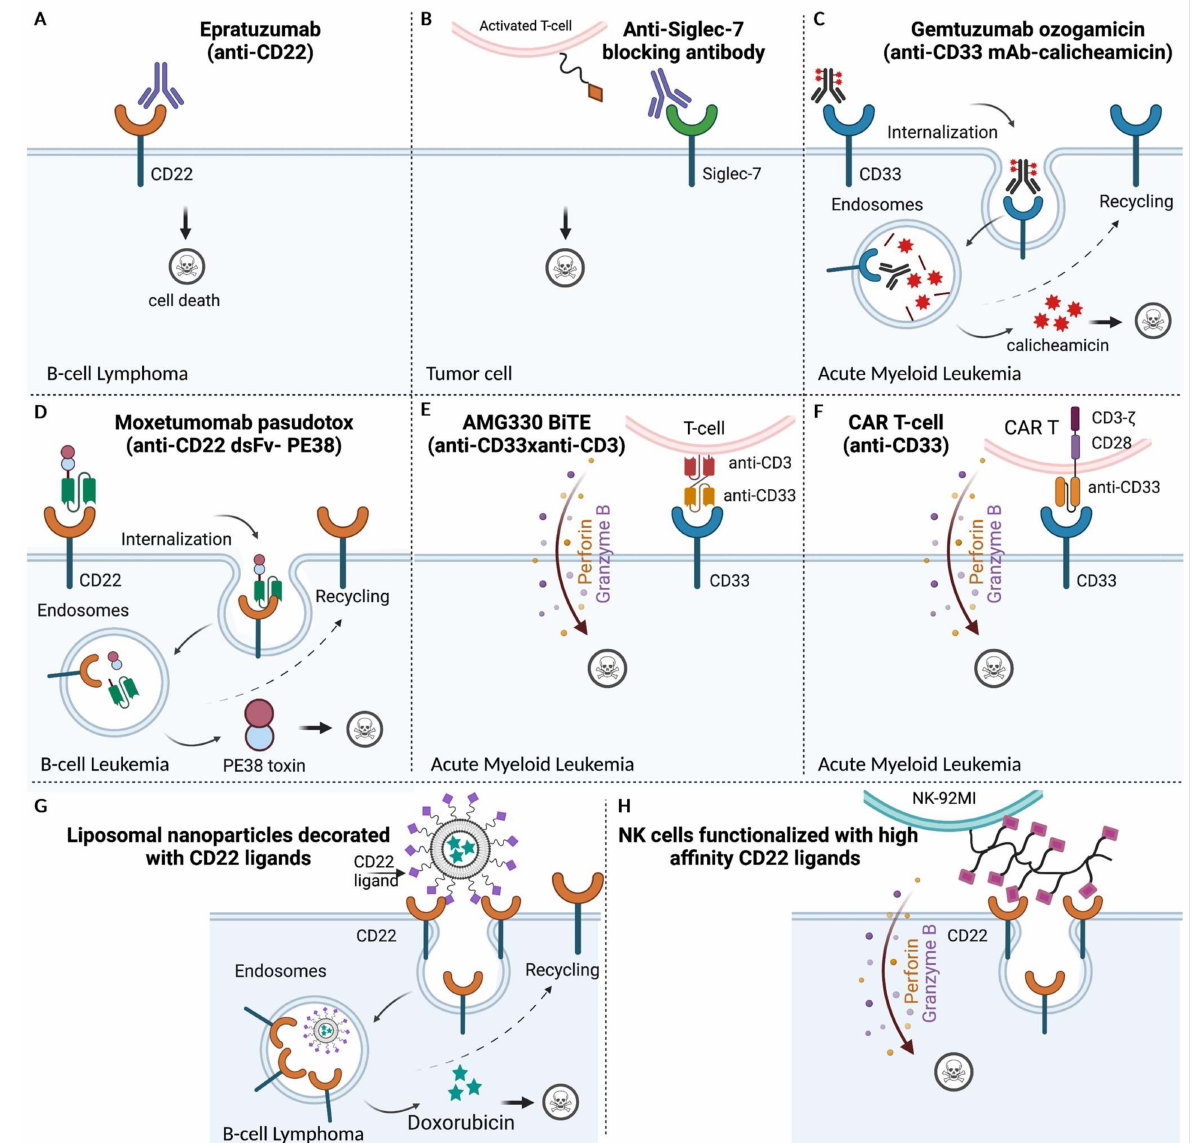
Figure 5. Siglec-directed strategies as therapeutics. The three modalities used to target Siglec receptors: ( A – D ) Anti-Siglec antibodies, ( E , F ) redirection of cytotoxic immune cells, and ( G , H ) high-affinity, multivalent Siglec-ligands. Antibodies mediate anti-tumor effects via different mechanisms: target cell depletion via ( A ) Siglec-specific monoclonal antibodies. Epratuzumab, a humanized mAb directed against the B-cell restricted antigen, CD22/ Siglec-2 on B-cell lymphomas, and ( B ) anti-Siglec-7 enhances T cell cytotoxicity by delivery of cytotoxic payloads to cancer cells via ( C ) Anti-Siglec antibodies conjugated to cytotoxic drugs such as Gemtuzumab ozogamicin (GO) that exploit the endocytic property of CD33 receptors for targeted delivery of cytotoxic drugs to CD33 + AML blasts; ( D ) Moxetumomab pasudotox, an immunotoxin derived from the scFv fragment of anti-CD22, fused to bacterial endotoxin, PE38, for the treatment of B-cell leukemia; Siglec-sialoglycan blockades using antibodies similar to ( A , E ), AMG330 BiTE enhances T cell cytotoxicity or ( F ) uses CAR-T cells to retarget the immune response towards tumor cells. Other strategies also include multivalent drug delivery platforms such as ( G ) liposomes and ( H ) glycoengineered cytotoxic NK cells modified with high-affinity Siglec ligands for selective targeting of tumor